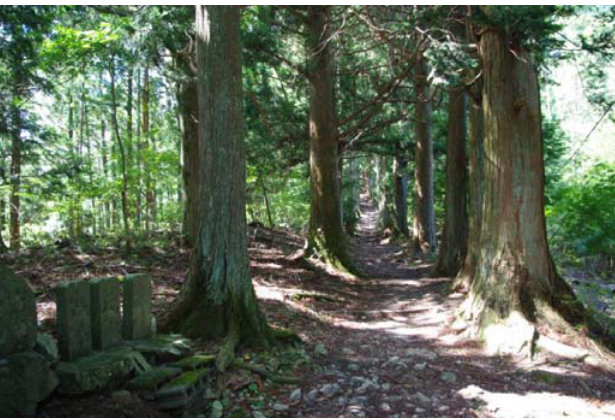
Figure 16. Trail for pilgrims to Keishin-in with stone monuments.